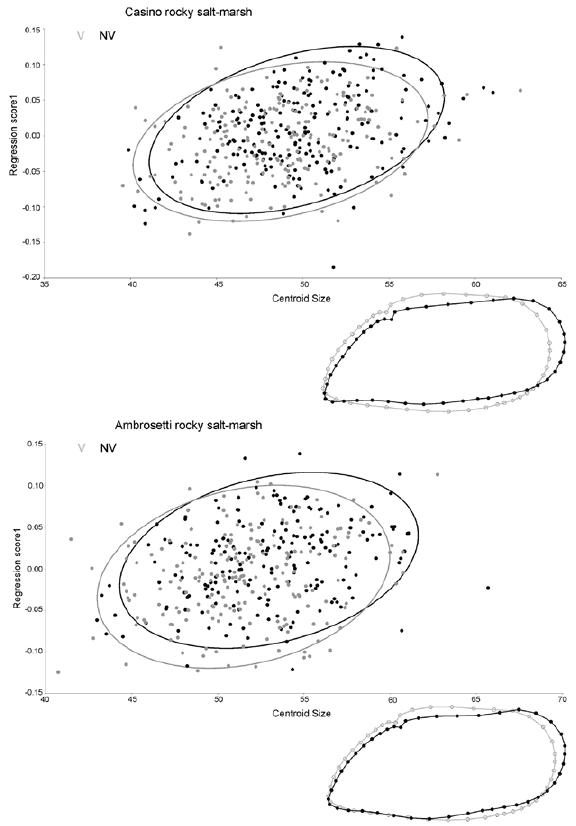
Fig. 4. – Regression of shell shape onto centroid size, illustrating allometric growth of shape of the scorched mussel Perumytilus purpuratus sampled from vegetated (V) and non-vegetated patches (NV) in the Casino and Ambrosetti rocky salt-marshes. The 95% equal frequency ellipses are shown for vegetated (V) and non-veg- etated (NV) patches and represent that each point has a probability of 0.95 of falling within the ellipse. The shell diagrams represent the shape change predicted from the average shape (grey wireframe) to an increment of 30 scale factor of centroid size (black